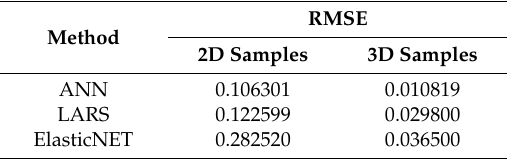
Table 2. Comparison of the quality of different imaging